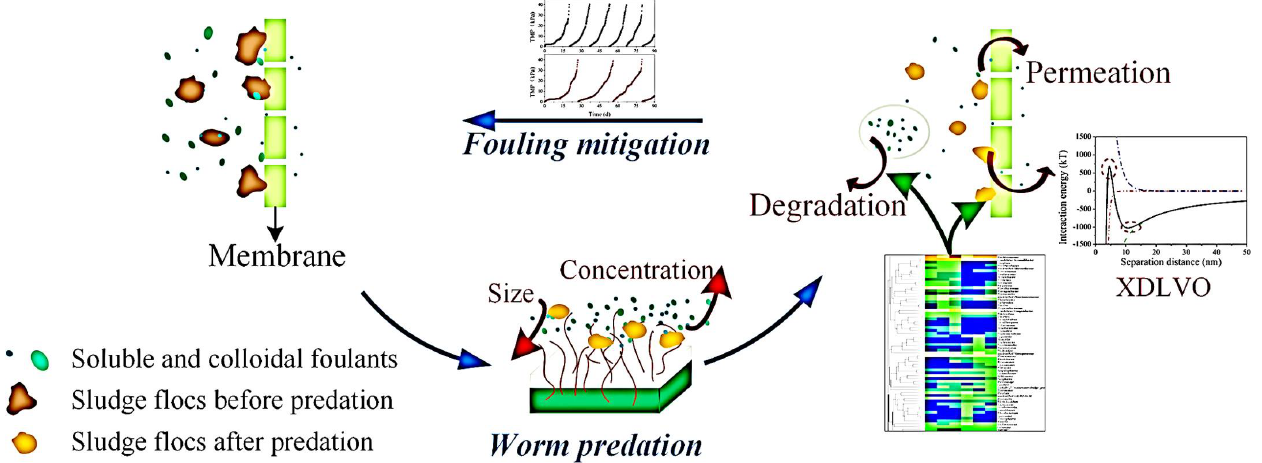
Figure 21. Established combined system of anaerobic-anoxic-oxic membrane bioreactor (A 2 O-MBR) and worm reactor (WR) for fouling control [119].